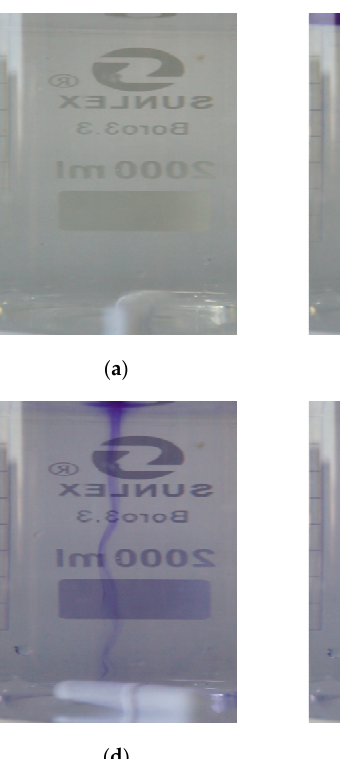
Figure 1. The dye around the beaker achieved complete mixing due to the stirring paddle, among which Fig a-f are RGB color gradient at the time of 0s( a ), 1mim ( b ), 2min( c ), 4mim( d ), 6min( e ) and complete mixing( f ), respectively.